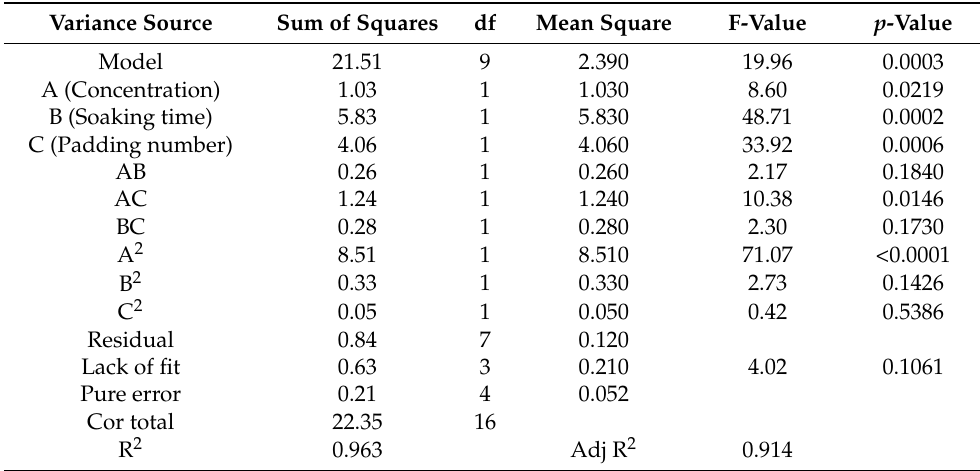
Table 4. ANOVA results for weight loss rate.